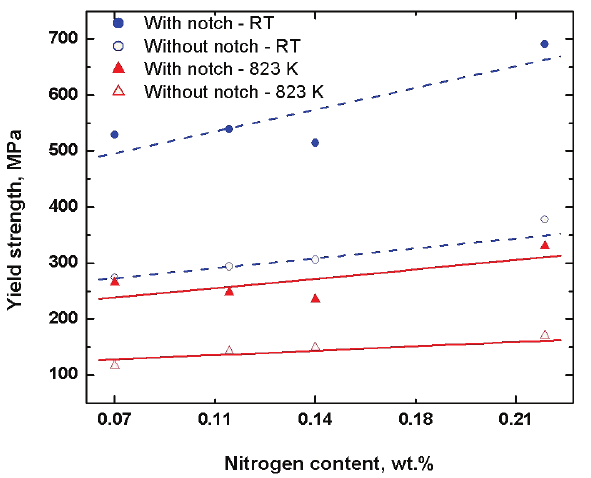
Figure 4. Variation of ultimate tensile strength with nitro- gen content at room temperature and 823 K.